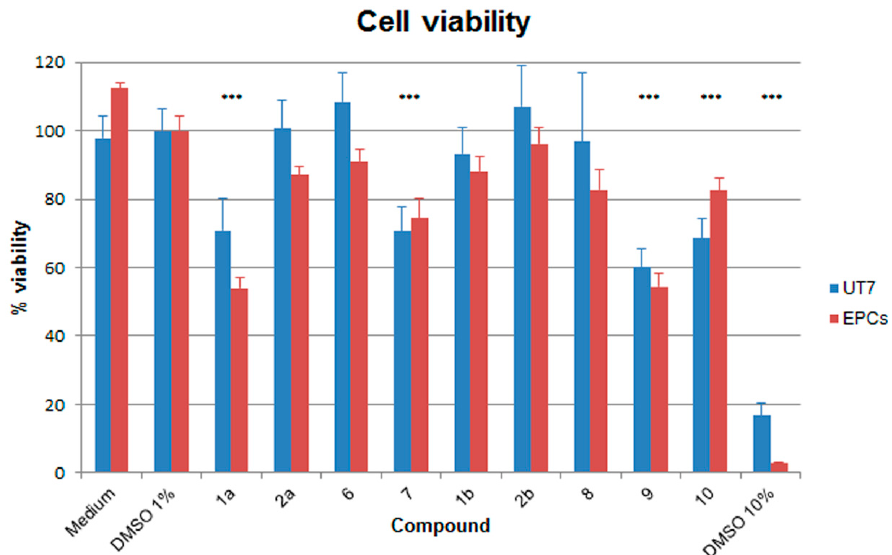
Figure 2. Percentage of viability of the UT7/EpoS1 and EPCs cells for different compounds compared to medium with 1% DMSO. The amounts of formazan dye produced by cells from the WST-1 reagent (CCK8 assay, Microtech) was measured as absorbance (OD) values, replicate net OD values were normalized with respect to the control samples and expressed as mean percentage values. Data were collected from triplicate wells in two different experiments; the statistical analysis was performed by one-way ANOVA (analysis of variance) followed by Dunnett’s multiple comparison test. *** p value <0.0001.